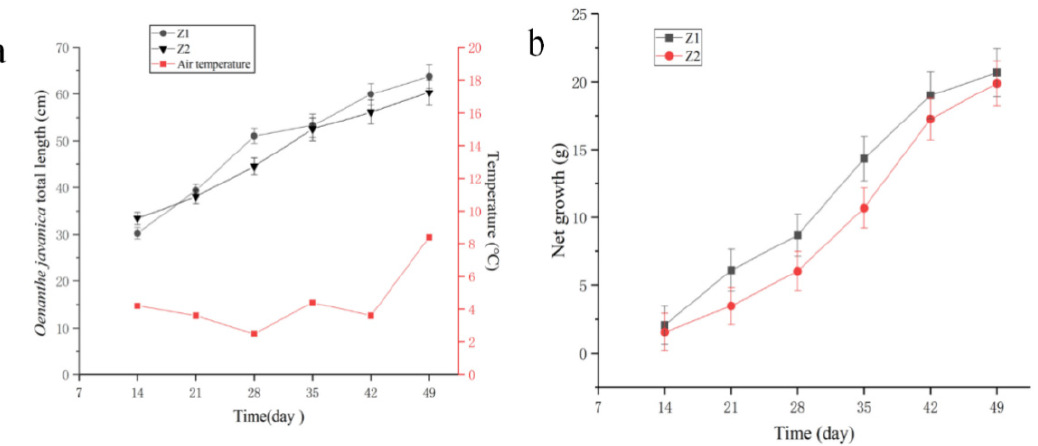
Figure 3. Variations of total length ( a ), net growth ( b ) of Oenanthe javanica in the different VSFCW units (Z1: added microorganisms unit; Z2: no added microorganisms unit).